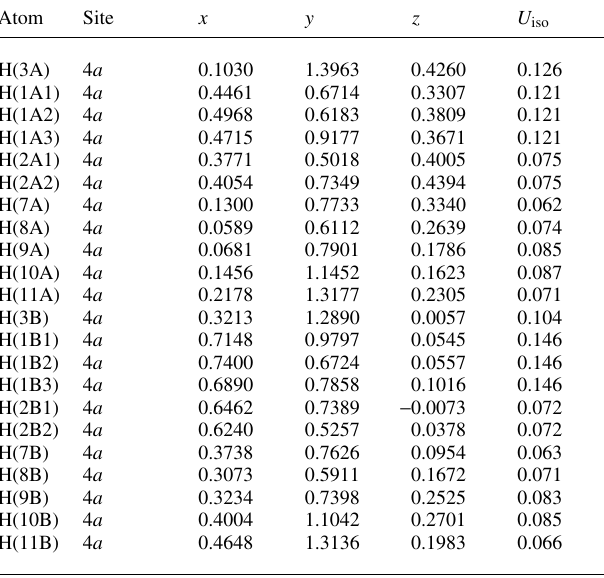
Table 2. Atomic coordinates and displacement parameters (in Å 2 )